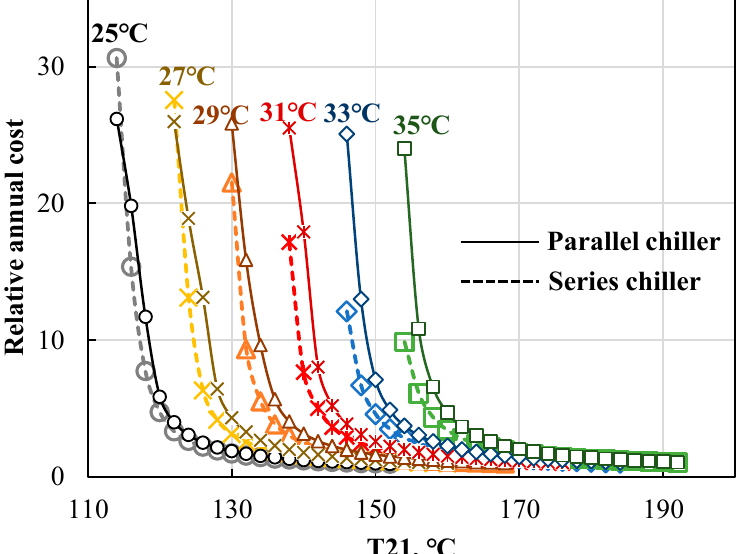
Figure 6. Variation in annual cost with two types of absorption chillers as functions of cooling temperature and steam temperature (T21).